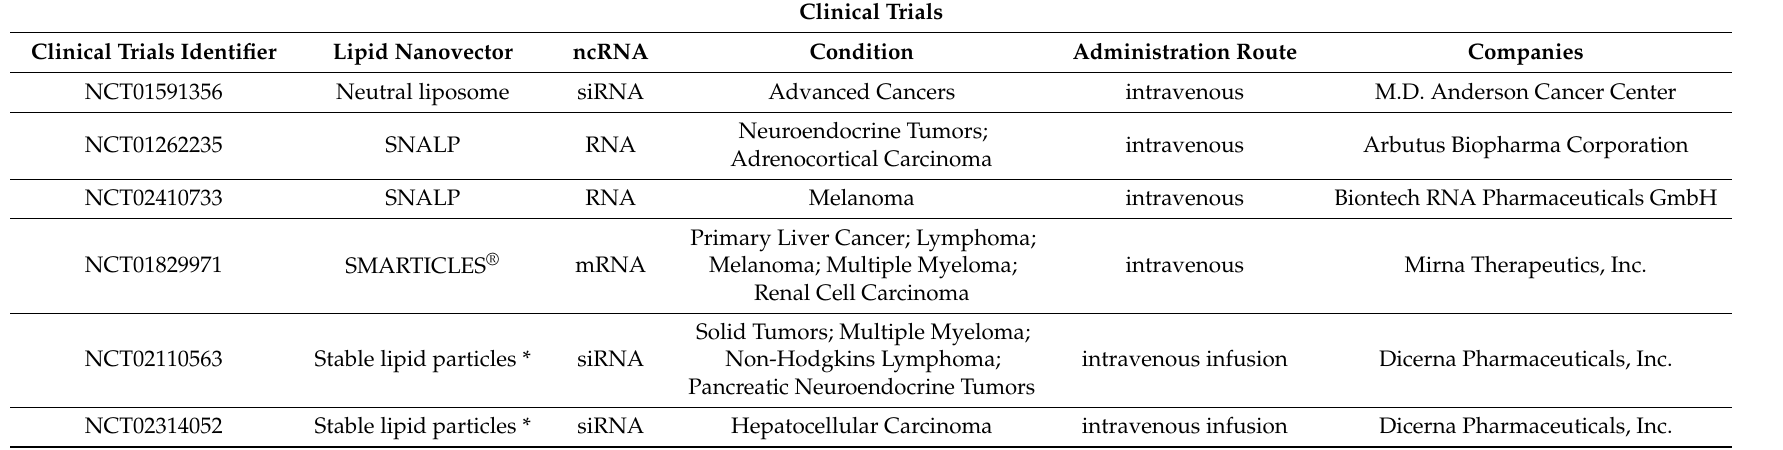
Table 2. Clinical trials involving lipid vesicles encapsulating ncRNA for cancer